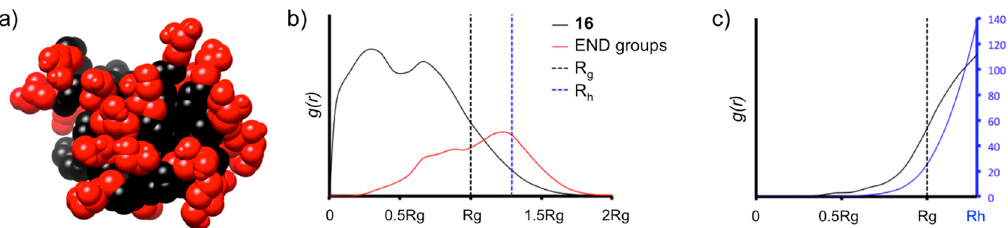
Figure 4. MD characterization of dendrimer 16 in water. ( a ) Equilibrated configuration of 16 —black: scaffold, red: OH-surface groups; ( b ) radial distribution functions g(r) of the atoms of 16 (black) and of the surface OH-groups (red) as a function of the distance from the dendrimer’s center of mass. The hydrodynamic radius of 16 is calculated according to the model of a rigid sphere as: R h ≈ 1.29 R g [28]; ( c ) radial distribution functions, g(r) , of the water molecules (black), and number of water molecules (blue) as a function of the distance from 16 ’s center of mass.